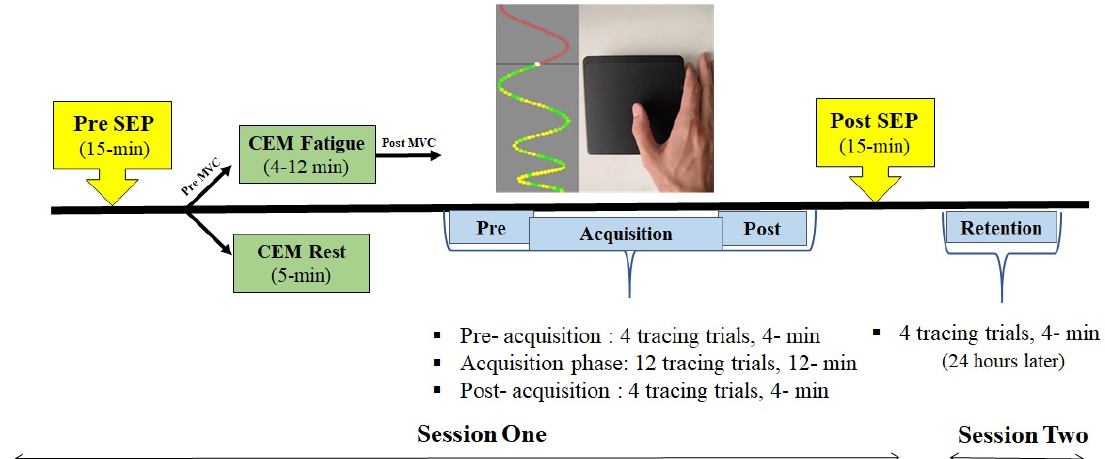
Figure 1. Experimental protocol: The first session started by obtaining the pre-SEP (baseline) measurements through the stimulation of the median nerve and then participants completed either cervical extensor muscle (CEM) rest or fatigue, depending on the group. Each participant completed the motor skill acquisition-tracing task, then post-SEP measurements were obtained. The second session measured retention 24 h after using the same pre- and post-motor skill acquisition task performed in session one. For motor skill acquisition, a tracing task of continuous sinusoidal waves move vertically down a monitor and participants attempted to copy each dot as it passed the black horizontal axis. Color coding of the dots show trace accuracy feedback with green representing a perfect trace and yellow indicating error.